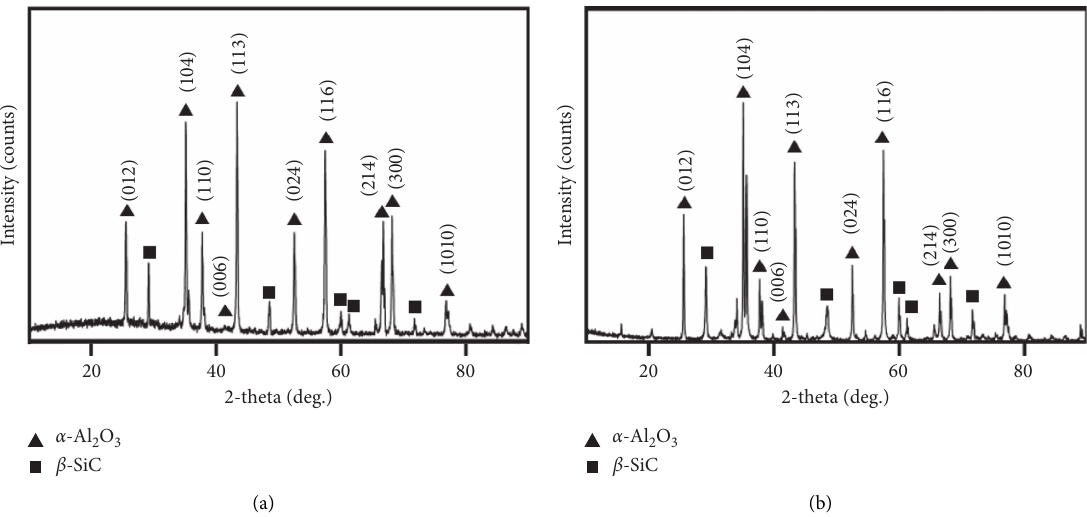
Figure 1: XRD pattern of Al 2 O 3 /10 wt.% SiC: (a) microwave sintered and (b) electrical resistance heating